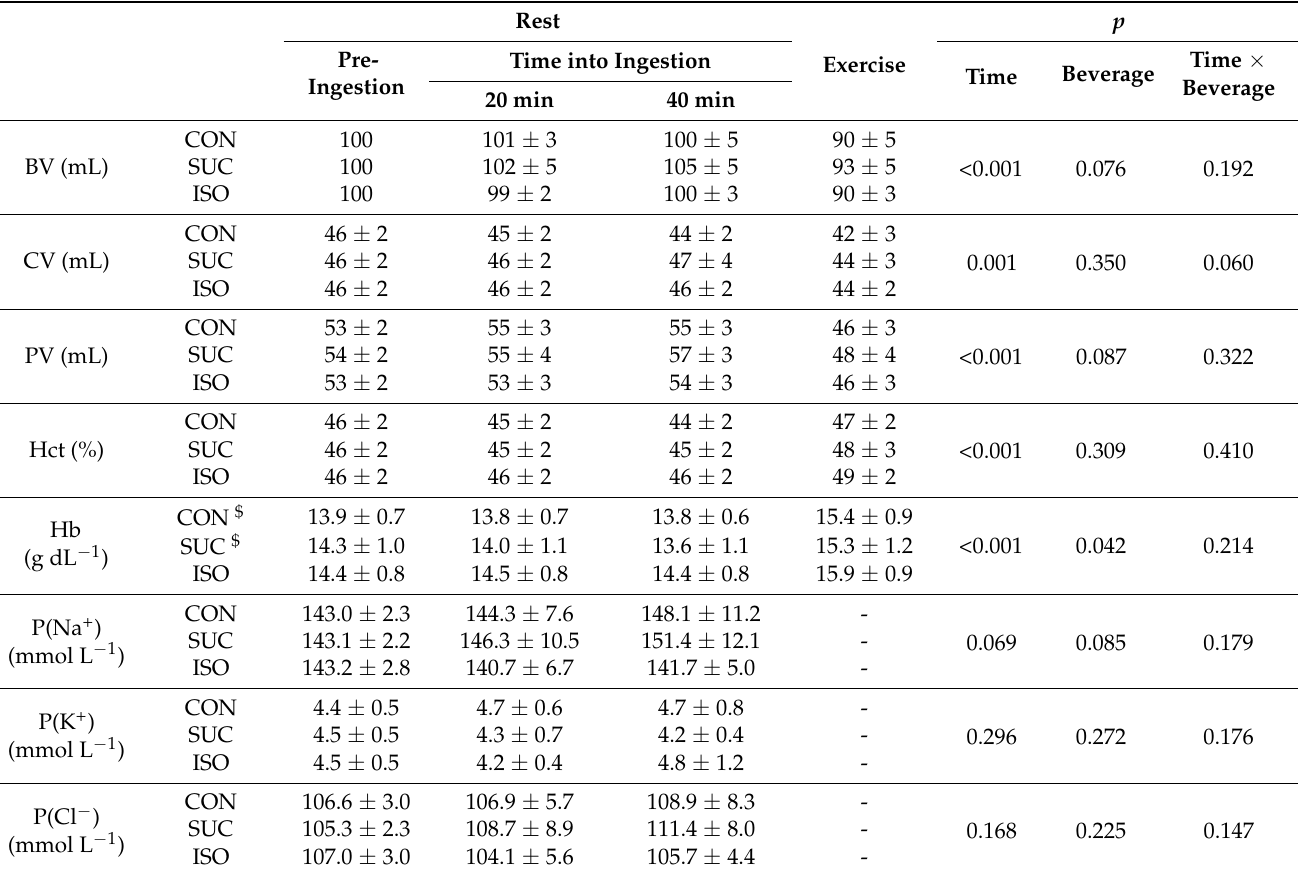
Table 2. Hematologic variables at rest and during exercise in each trial. Rest Exercise